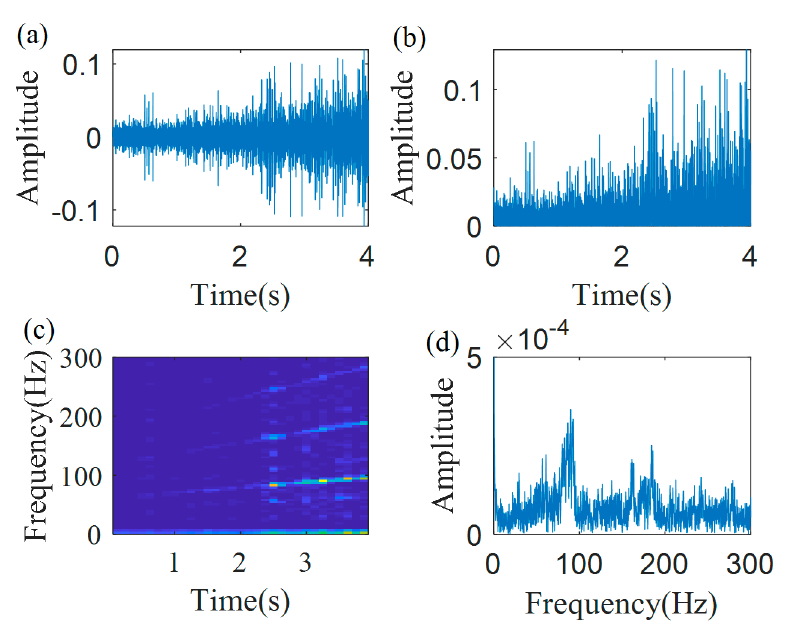
Figure 17. Raw signal: ( a ) signal; ( b ) envelope signal; ( c ) TFR; and ( d ) the spectrum.